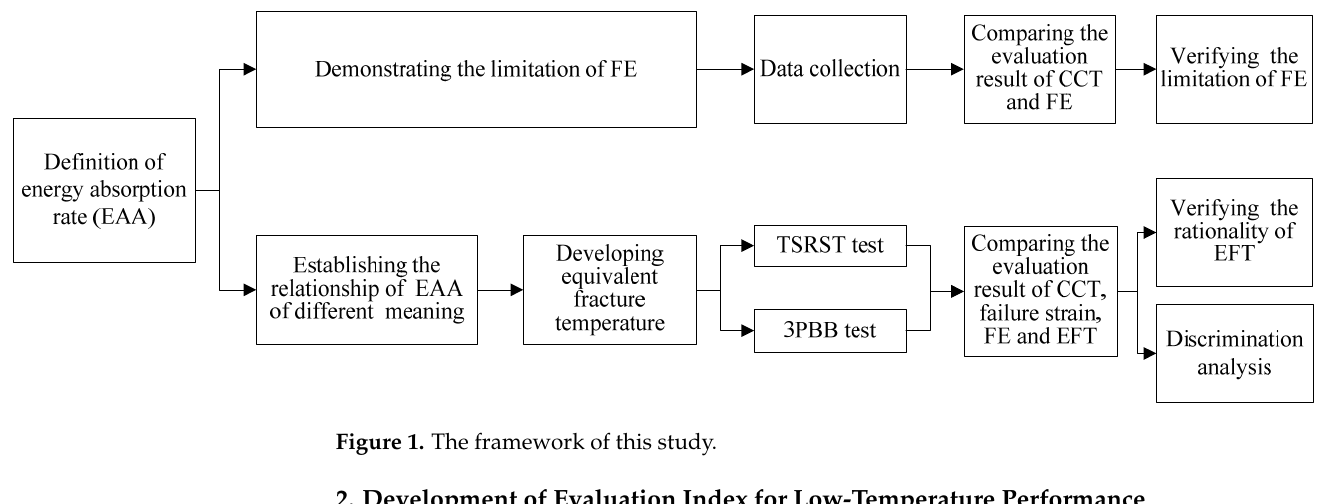
Figure 1. The framework of this study.